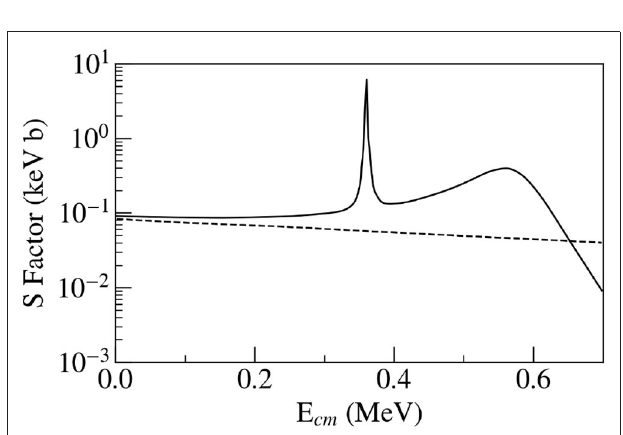
FIGURE 11 | S-factor of the total direct proton capture 18 O(p, γ ) 19 F determined from the transfer reaction. The red solid decreasing curve is based on the measurement of the direct contribution (p, γ ) by Wiescher et al. (1980) with uncertainty about 7% (dashed red curves).